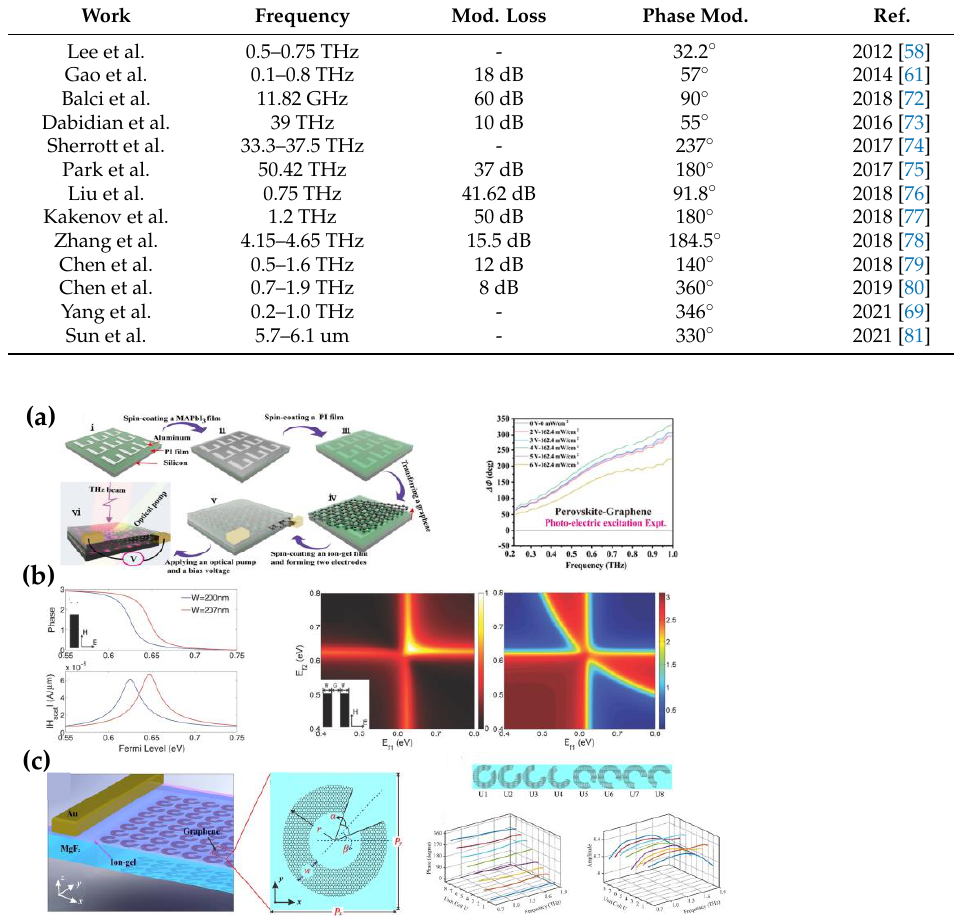
Figure 5. The transmissive tunable graphene terahertz phase modulator. ( a ) Fabrication process of the photoelectric metasurface composed of graphene, polyimide, and perovskites, transmission phase difference of the perovskite − graphene metadevice under photo − electric excitation; (Reprinted with permission from ref. [69] Copyright 2022, American Chemical Society) ( b ) Phase shift and magnetic field amplitude of scatters by graphene plasmonic resonance for an infinitely long nanoribbon versus the Fermi level, where the magnetic field amplitude drops sharply from the resonance region; the magnetic field amplitude and phase shift are enhanced under two independent Fermi levels of two parallel nanoribbon; (Reprinted with permission from ref. [82] Copyright 2014, Wiley − VCH) ( c ) Monolayer graphene split-rings are transferred on the MgF2 with a layer of ion-gel on top for polarization modulation, the vertical view of split-ring with geometrical parameters; the eight units with different opening angles form one supercell, covering 360° phase response with an amplitude of nearly 0.4. (Reprinted with permission from ref. [80] Copyright 2019, Elsevier)